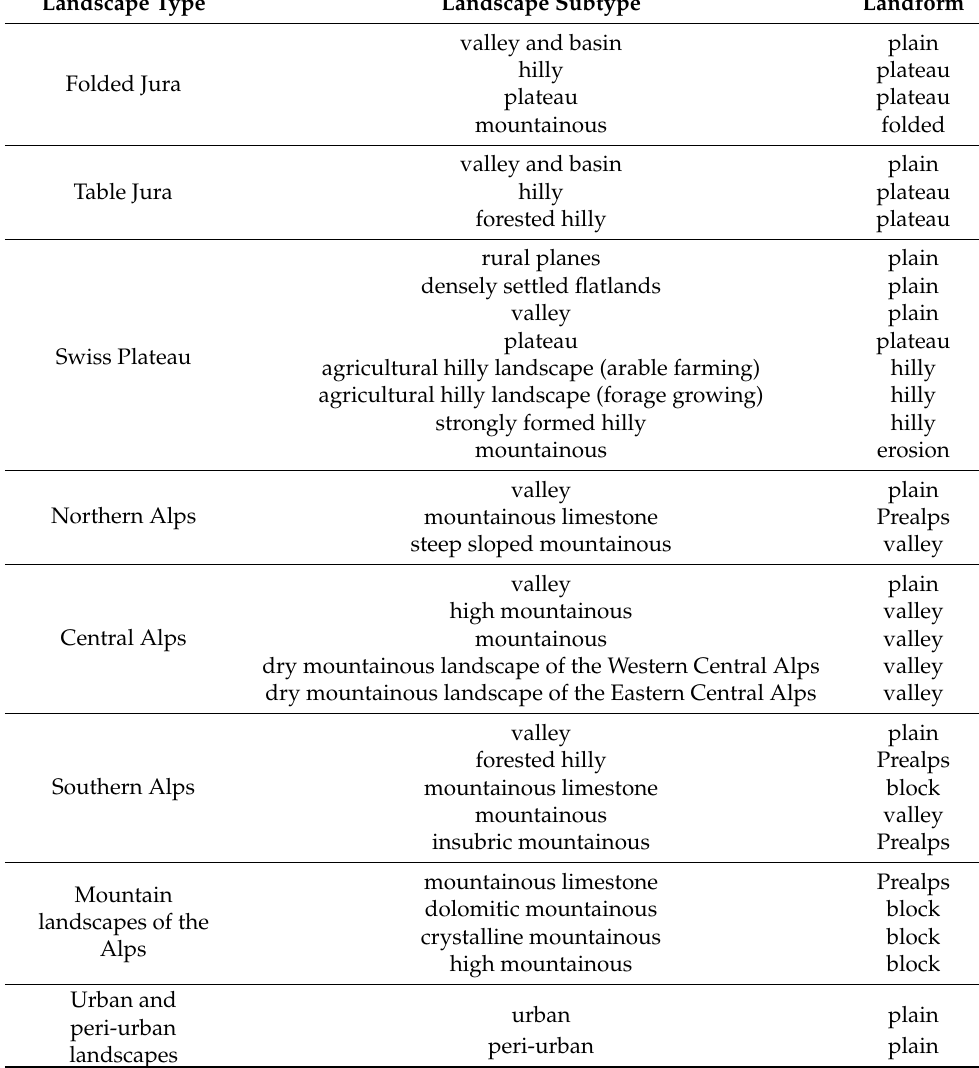
Table 2. Swiss landscape types and assigned landforms. Landscape Type